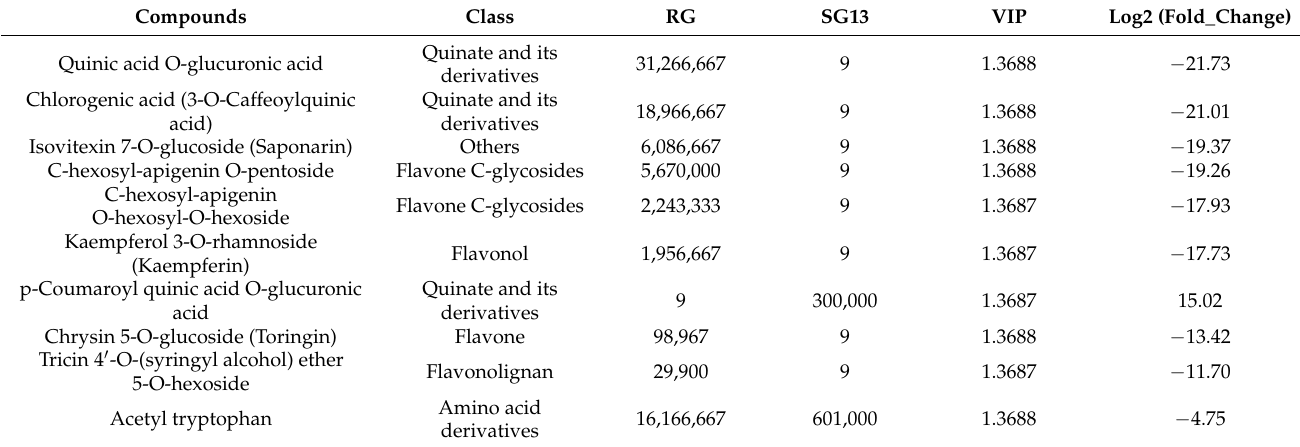
Figure 3. VIP (variable importance for projection) plot of differentially accumulated metabolites in RG vs. SG13 leaves. Red dots are metabolites accumulated more in RG, and green dots are metabolites accumulated more in SG13. Differentially accumulated metabolites were defined as those with a fold change ≥ 2 or ≤ 0.5, and variable importance for projection (VIP) value > 1. Differentially accumulated metabolites with high VIP values were mainly flavonoids, flavonols, quinate and its derivatives, such as quinic acid O-glucuronic acid, chlorogenic acid, and apigenin derivatives. The top 10 different metabolites by VIP value were all accumulated more in RG (Table 1), while the metabolites accumulated more in SG13 were mainly flavone glycosides. Table 1. List of top 10 metabolites by variable importance for projection (VIP)